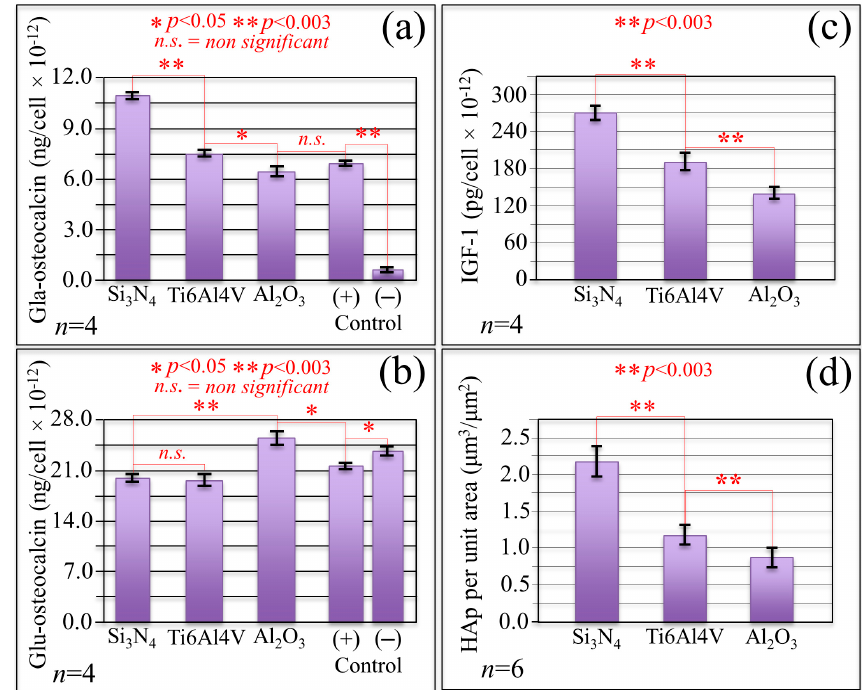
Figure 3. In ( a ) and ( b ), comparative plots of Gla- and Glu-osteocalcin, respectively, for cells exposed for nine days to different substrates; in ( c ), a similar evaluation is shown for IGF-1; ( d ) gives a plot of the volume per unit area of bony apatite grown by cells after exposure for 14 days to different substrates. Statistics were made according to one-way Analysis of Variance (ANOVA).